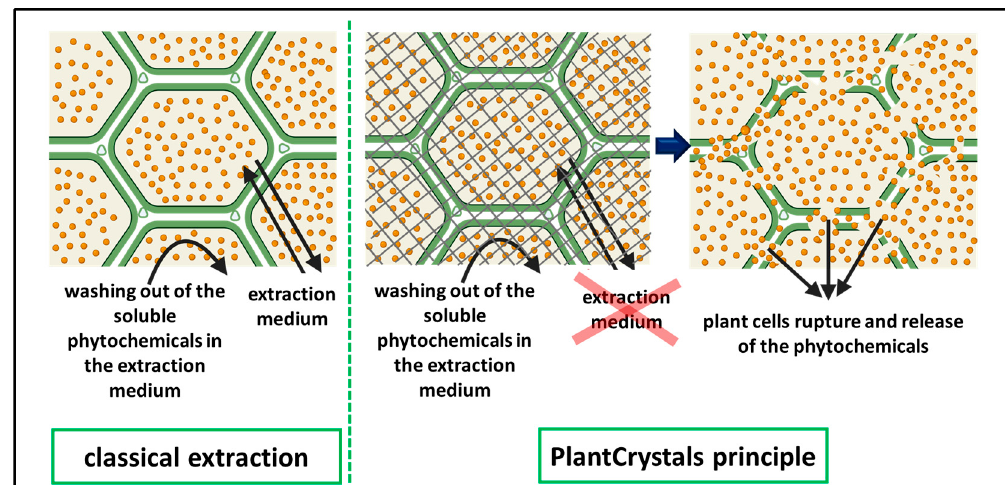
Figure 1. A scheme showing the principle of PlantCrystal technology in comparison with classical extraction process. The green lines represent the plant cells and the yellow round particles represent the phytochemicals inside the plant cells. The grey net (in the middle image) represents the forces applied during bead milling (BM) for plant cell rupture [8].